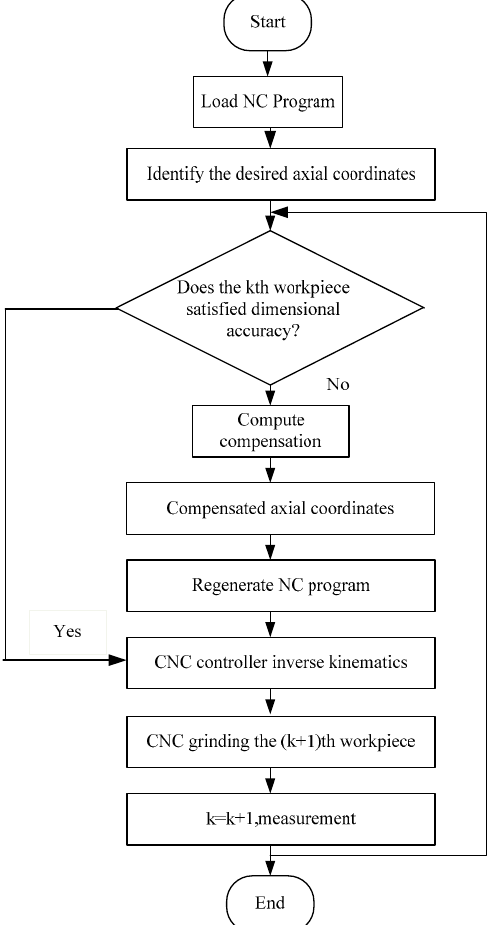
Figure 4. Flowchart of dimensional error compensation method.